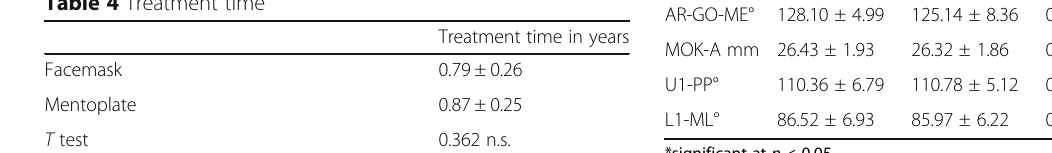
Table 4 Treatment time